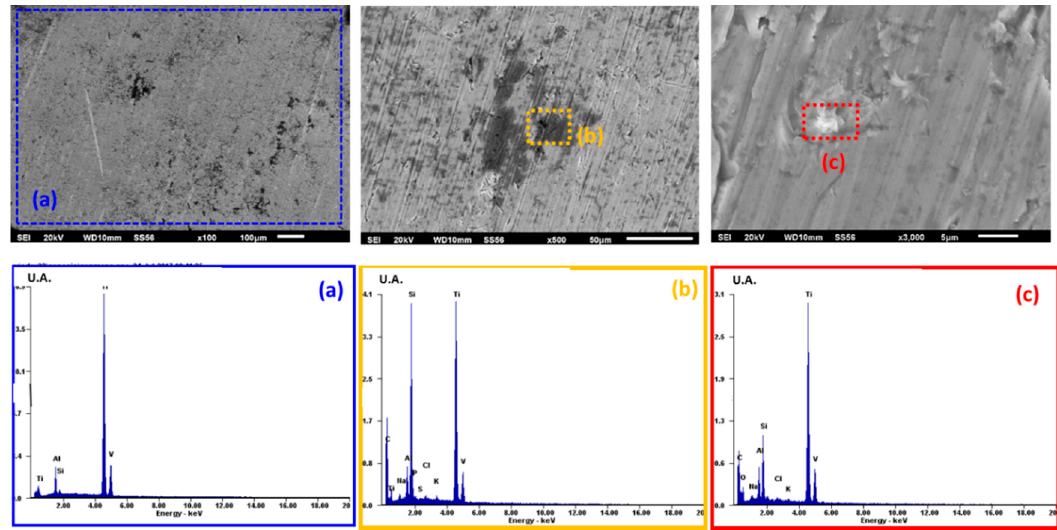
Figure 4. SEM surface morphology micrographs and EDS spectrum of Ti6Al4V in Streptococcus gordonii: ( a ) 100X, ( b ) 500X, and ( c ) 2000X.